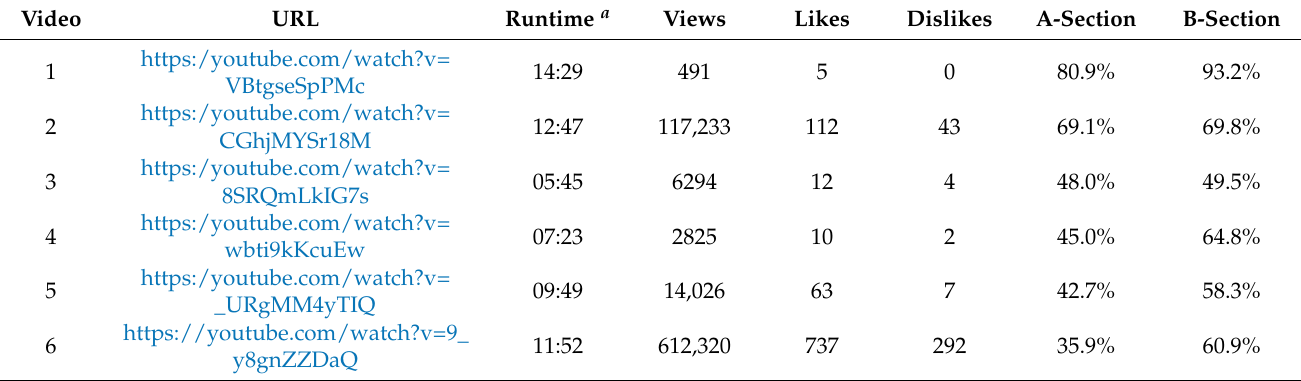
Table 2. Top rated